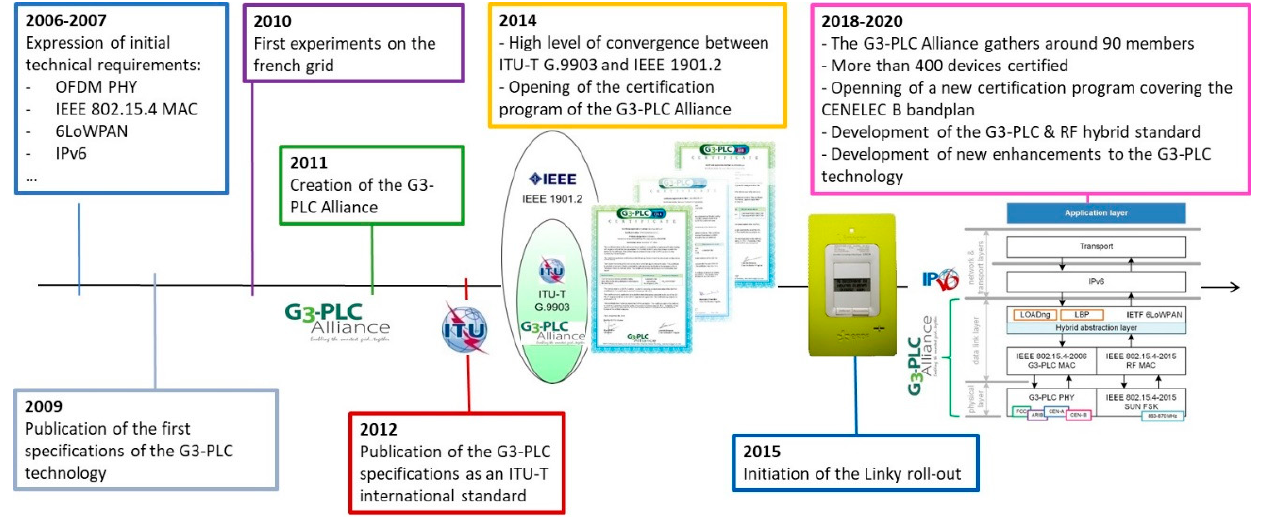
Figure 2. History of the G3-PLC technology.